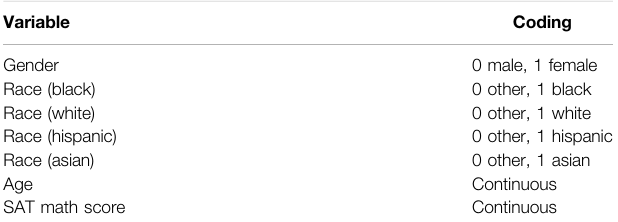
TABLE 1 | Coding for Baseline Covariates. By Dina Ghazzawi, Donna Pattison, and Catherine Horn. Variable